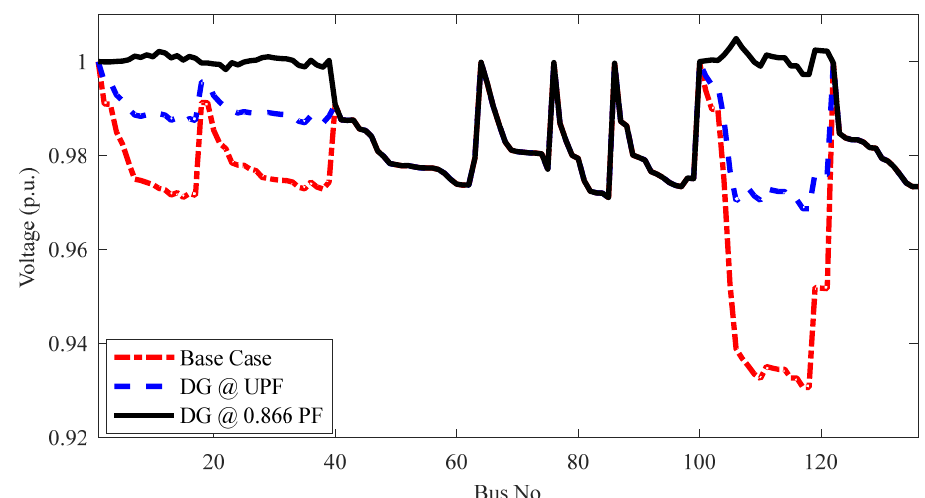
Figure 17. Comparison of the convergence characteristics of the SCA, DEA and O-SCMDEA for both cases of scenario IV of the 136 bus system.